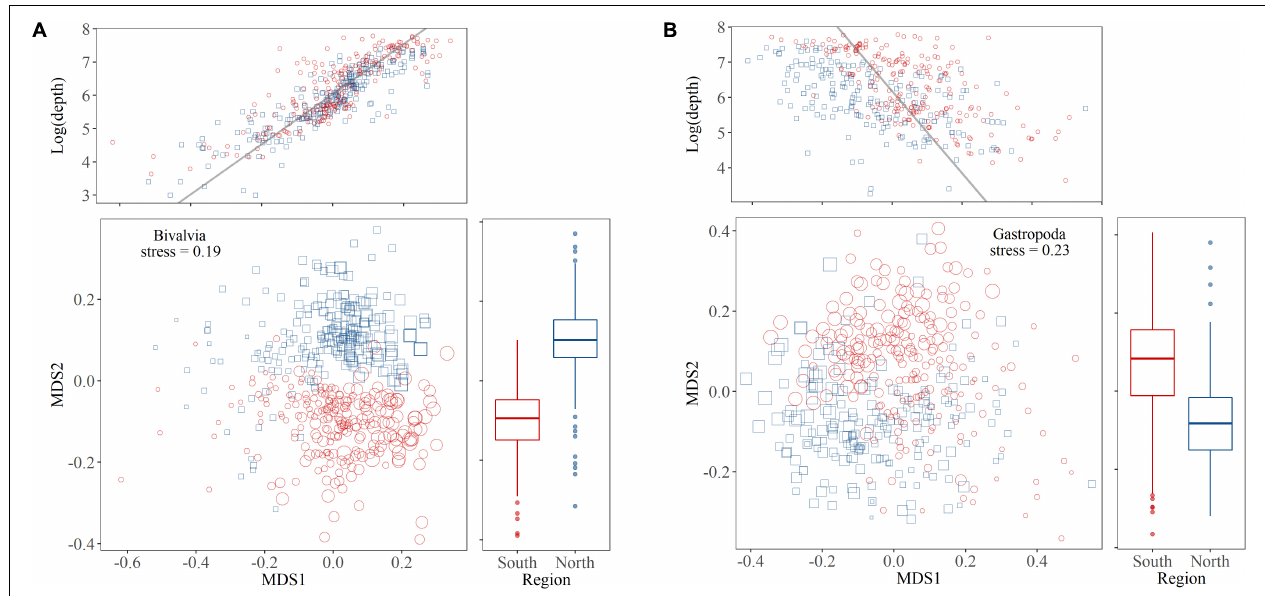
FIGURE 4 | Two-dimensional non-metric multidimensional scaling (NMDS) plots for (A) bivalve and (B) gastropod assemblages. For each class a central plot shows the results of the analysis with sample data representing the Iceland Sea basin north of the GIF ridge (blue squares) and the region south of the GIF ridge (red circles). The point size relates to the logarithm of sample depth. On top is a correlation of the MDS1 scores and the logarithm of depth which was significant in bivalves and gastropods and to the right a boxplot shows the significant regional difference for MDS2 scores in both